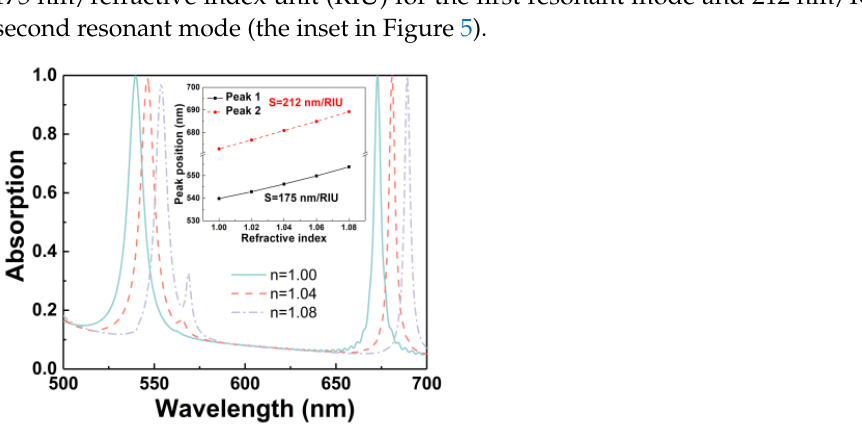
( b ) Figure 4. ( a ) Absorption spectrum for different width of nanocavity. ( b ) The relation between FWHM of absorption peak and width. For sensing applications, the resonant wavelengths of the designed metamaterial absorber are dependent on the refractive index of the surrounding dielectric environ- ment. The influence of the refractive index on absorption properties can be explained by the change in the capacitance of the structure. The relationship of the refractive index n and dielectric constant ε is expressed as n = ε 1/2 . The capacitance C of the equivalent in- ductor — capacitor (LC) circuit can be expressed as C = ε 0 n 2 σ eff / w. When the refractive in- dex of the surrounding media increases, the capacitance value increases due to the die- lectric constant, and the resonances redshift towards a longer wavelength. In order to ensure a good sensor performance of the all-dielectric metamaterial absorber, the refrac-